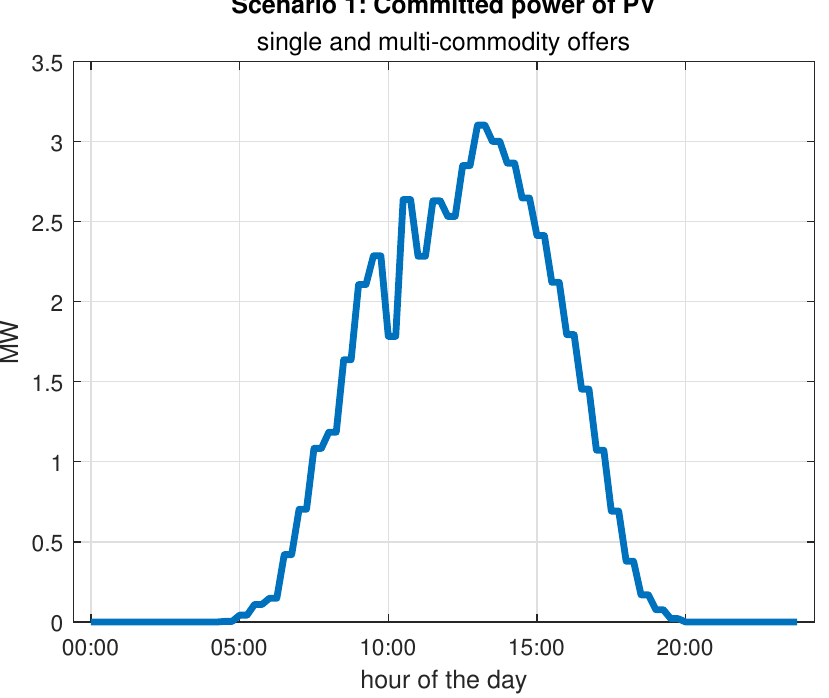
Figure 5. PV generation profile when both single and multi-commodity offers are